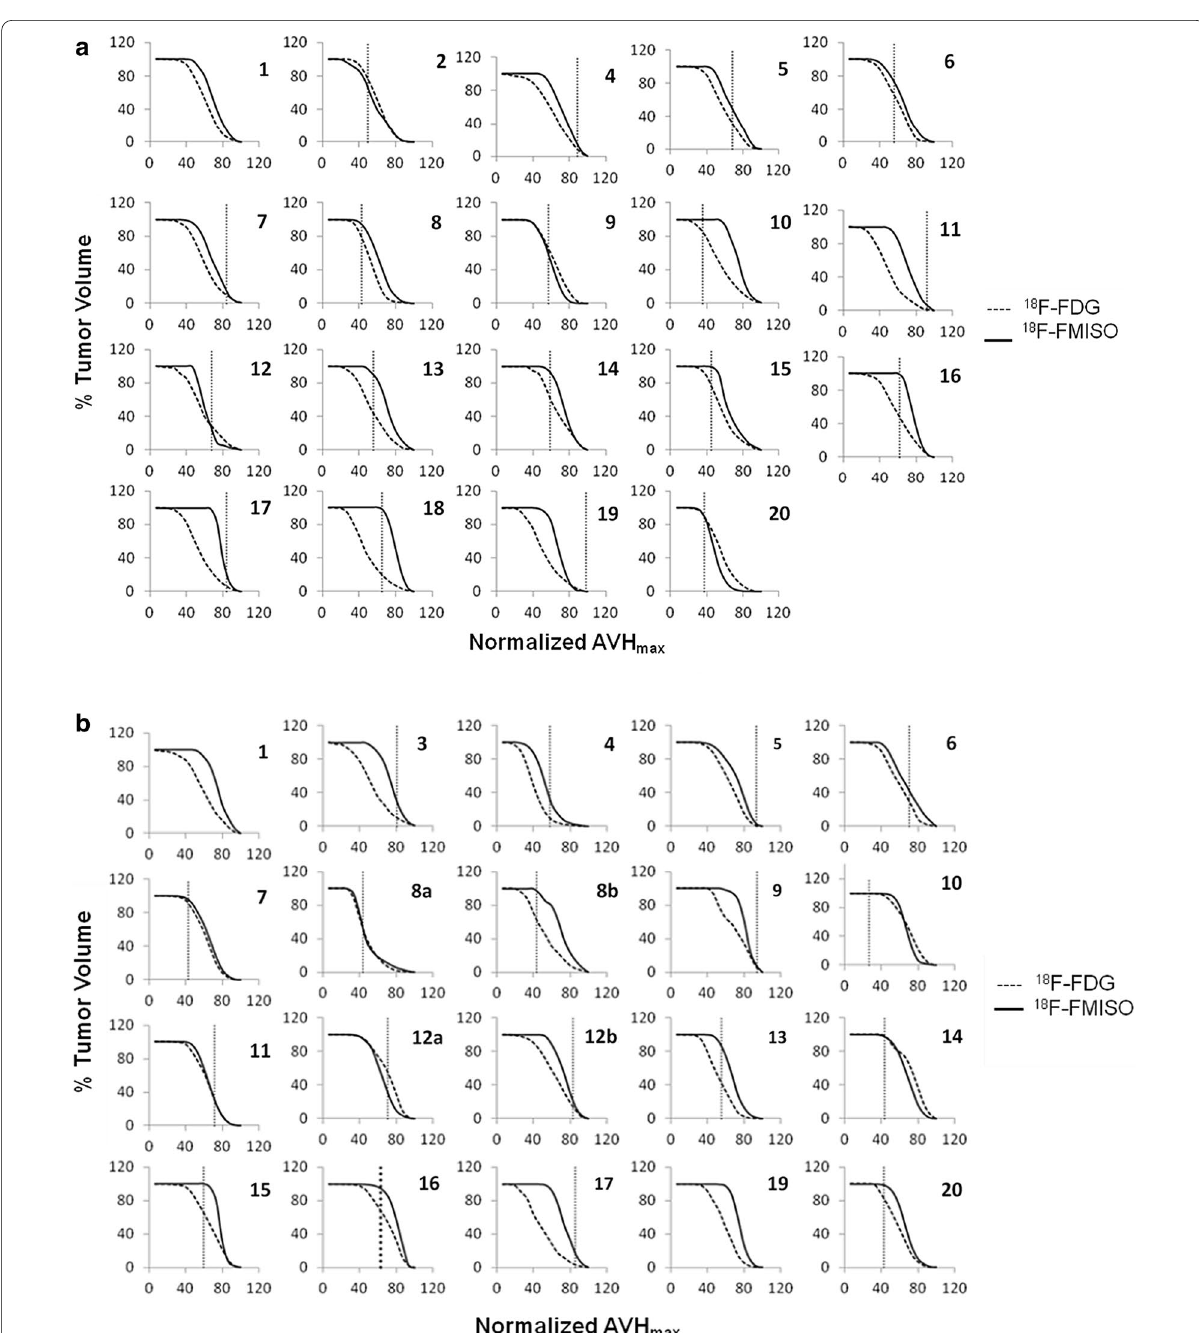
Fig. 5 Overlays of the FMISO and FDG activity volume histograms (AVH) of the primary tumors ( a ) and LNs ( b ). Differences between the FDG and FMISO intra-tumoral distribution in the primaries ( a ) and LNs ( b ) by means of a measure of the areas under the corresponding AVH’s appears to be statistically significant. The primary tumors and LNs FMISO AVH’s are shown in figure ( c ). FMISO intra-tumoral distribution in the primaries and LNs appears, however, to be